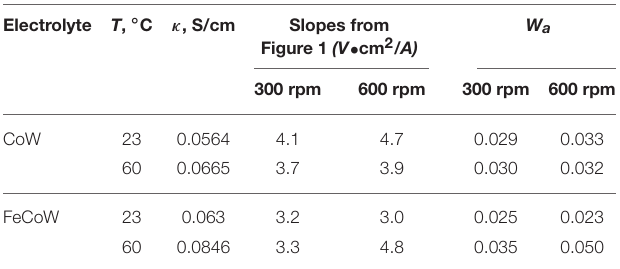
TABLE 1 | Estimated Wagner numbers. Electrolyte T , ◦ C κ ,